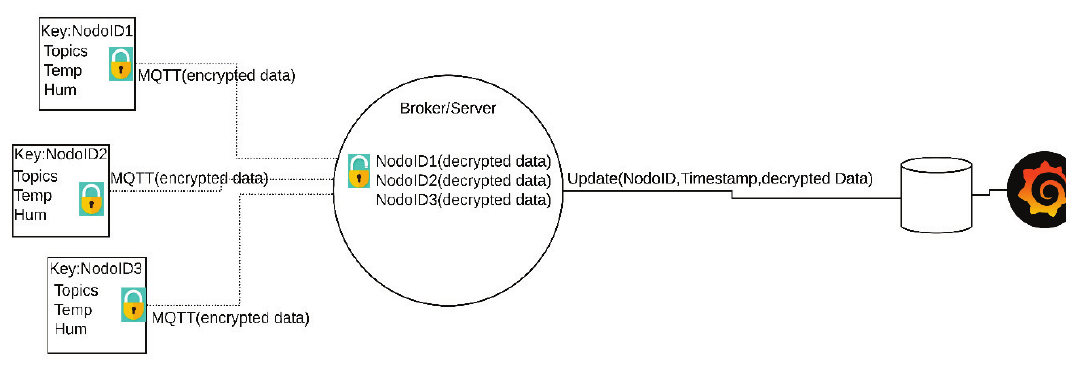
Figure 5. Data encryption operating scheme with the Message Queue Telemetry Transport (MQTT) communication protocol.